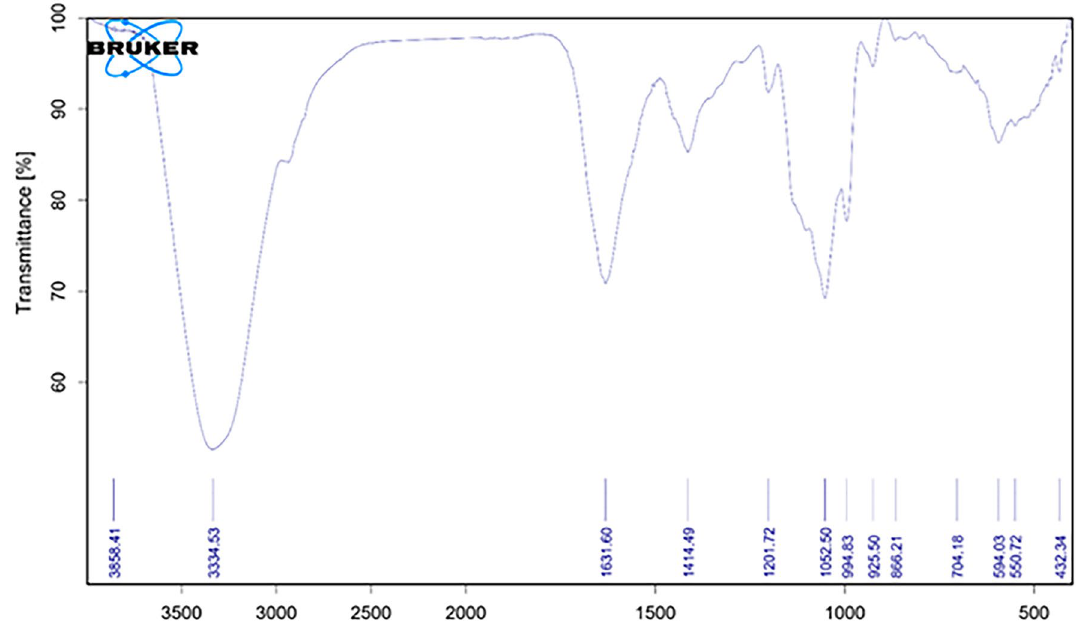
Fig. 3 FT-IR spectrum of crude methanolic extract of Enhalus acoroides (L.f.) Royle